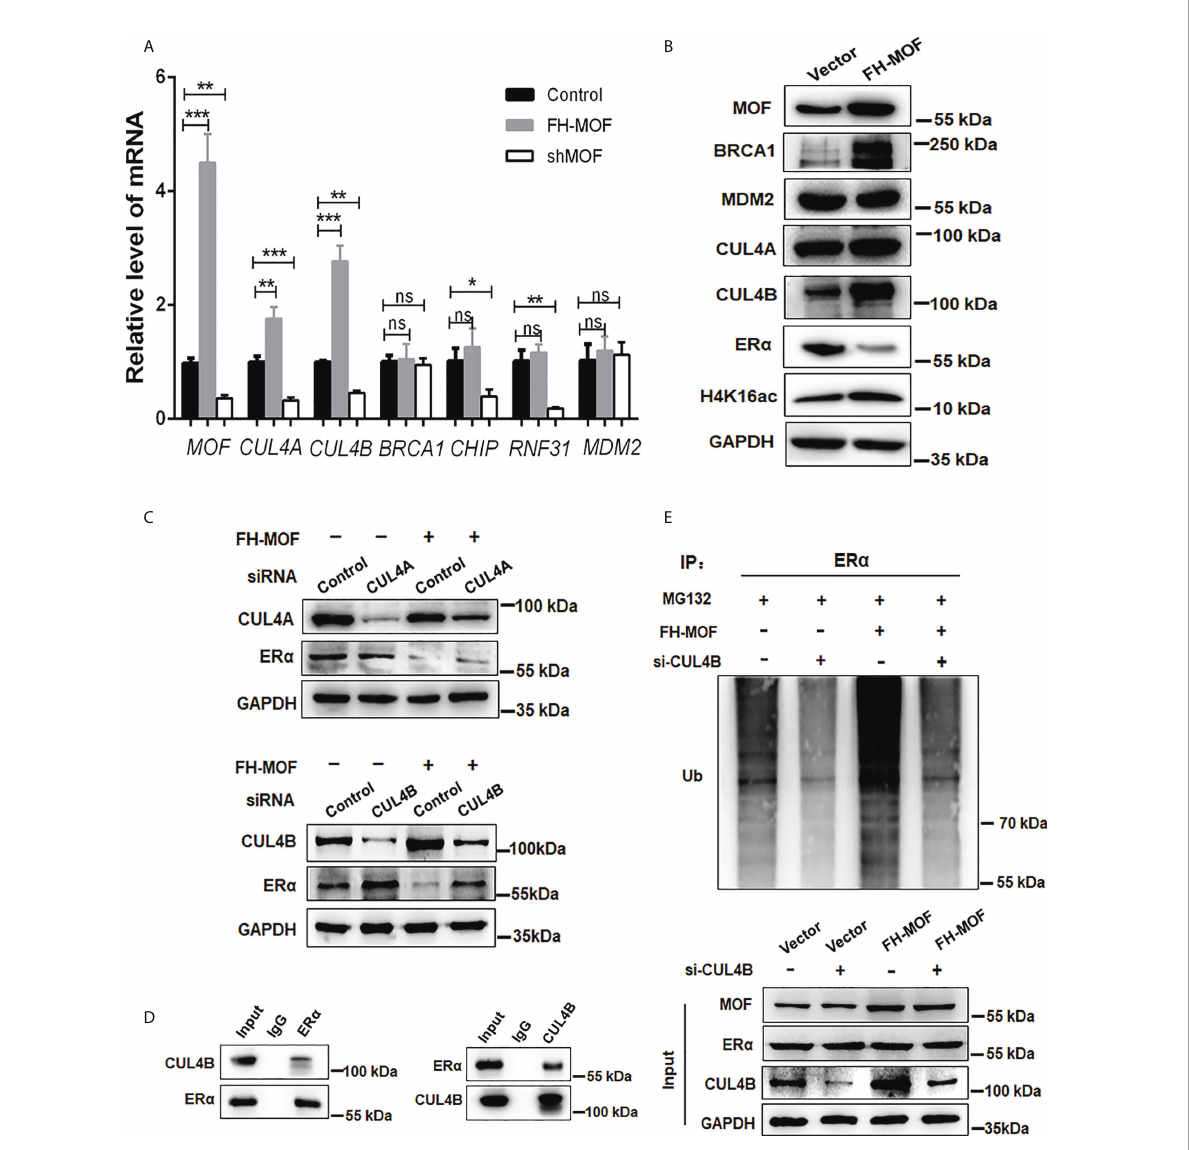
FIGURE 5 CUL4B is required for MOF-induced ER a protein degradation. (A, B) The mRNA and protein levels of candidate E3 ligases were determined by qRT-PCR and Western blotting in MCF7 cells with MOF overexpression. (C) Knockdown of CUL4B but not CUL4A could abrogate MOF-induced ER a protein degradation by WB assay. (D) Co-IP was performed to detect the physical interaction between MOF and ER a by using speci fi c antibodies against the two proteins. (E) The levels of polyubiquitin-conjugated ER a was determined by Co-IP to examine the involvement of CUL4B in the ubiquitination and protein degradation of ER a . ***P < 0.001, **P < 0.01, and *P < 0.05 vs. control group. ns, not signi fi cant vs. control.